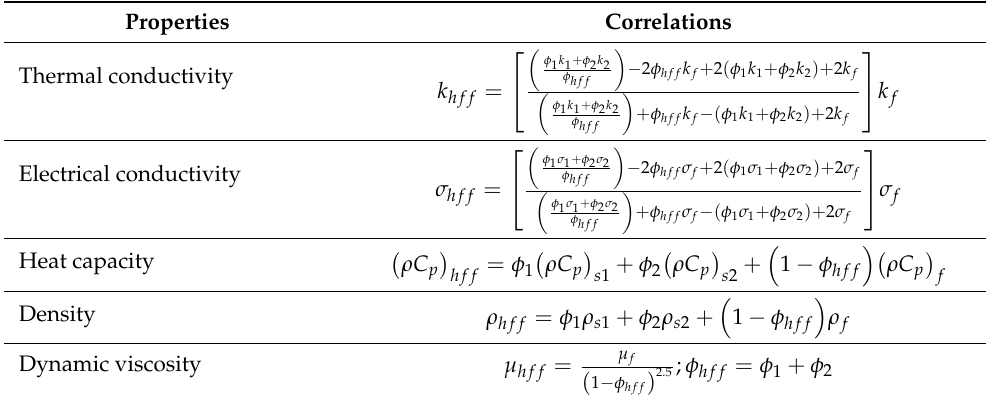
Table 2. General correlations of hybrid